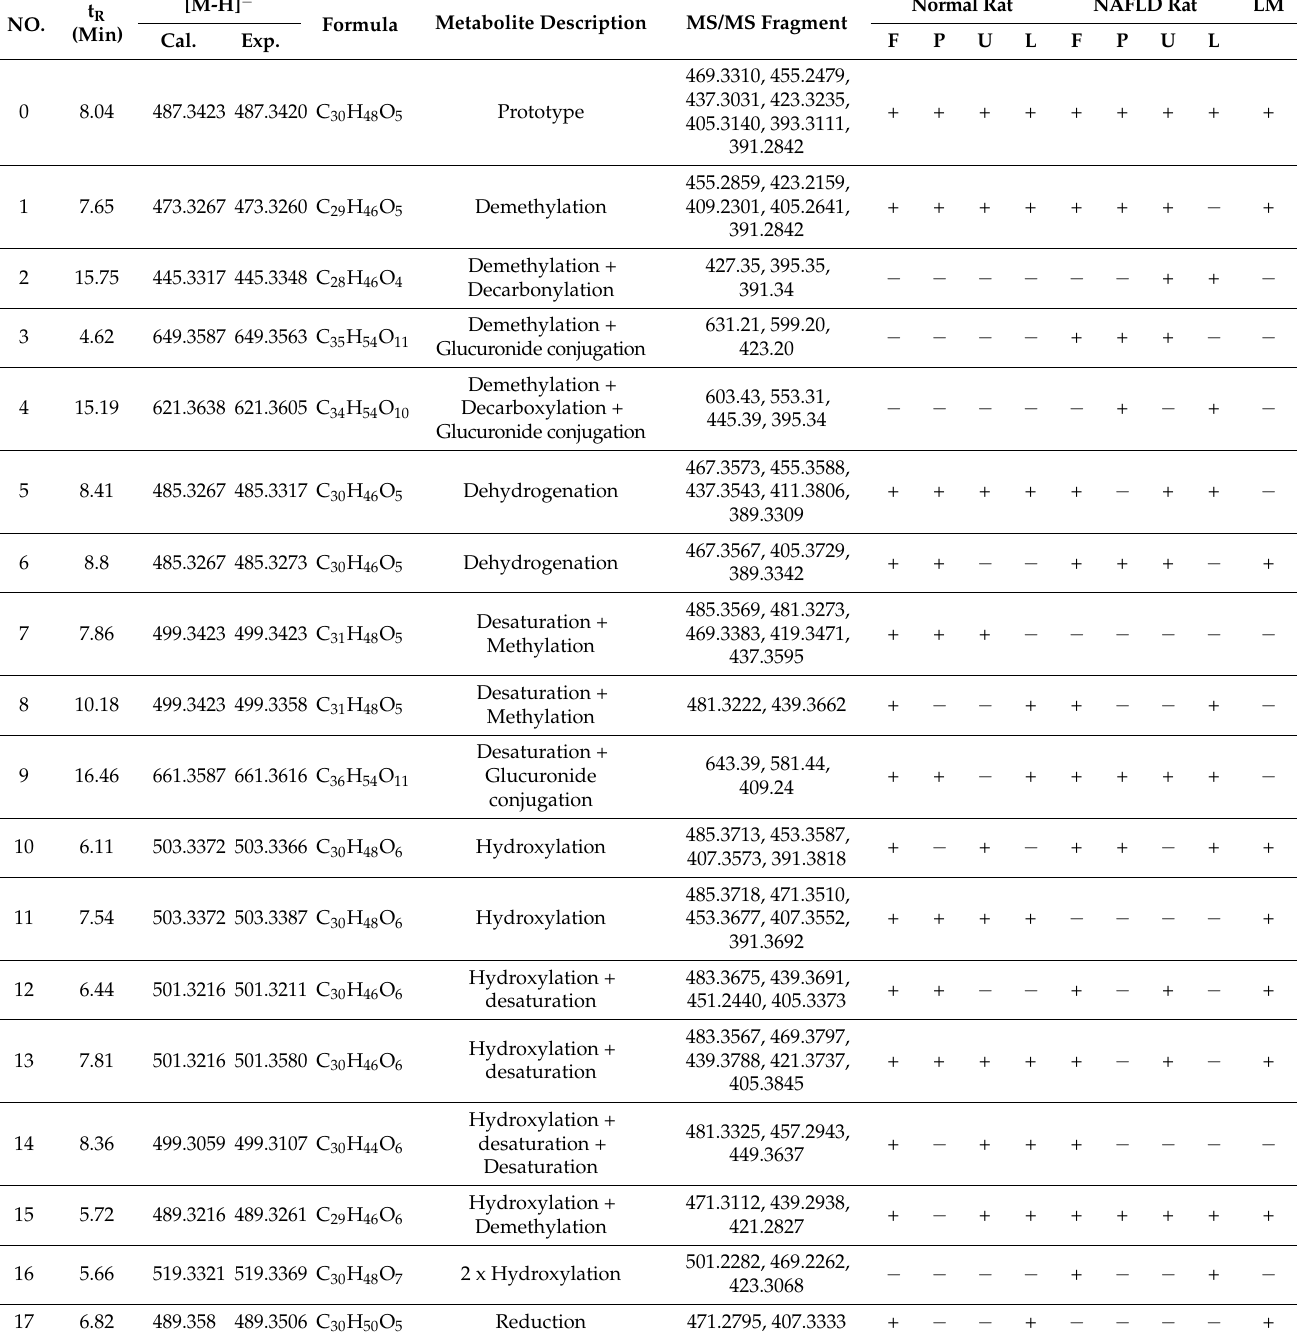
Table 1. The metabolite information of